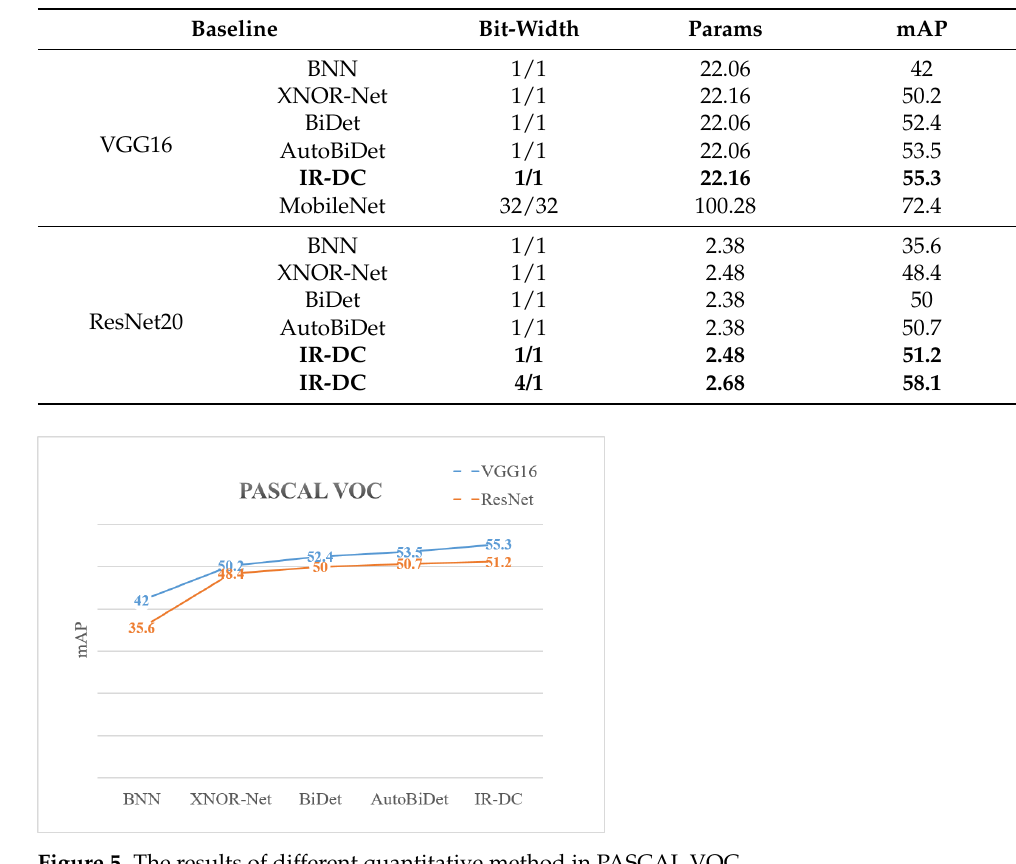
Figure 5. The results of different quantitative method in PASCAL VOC.